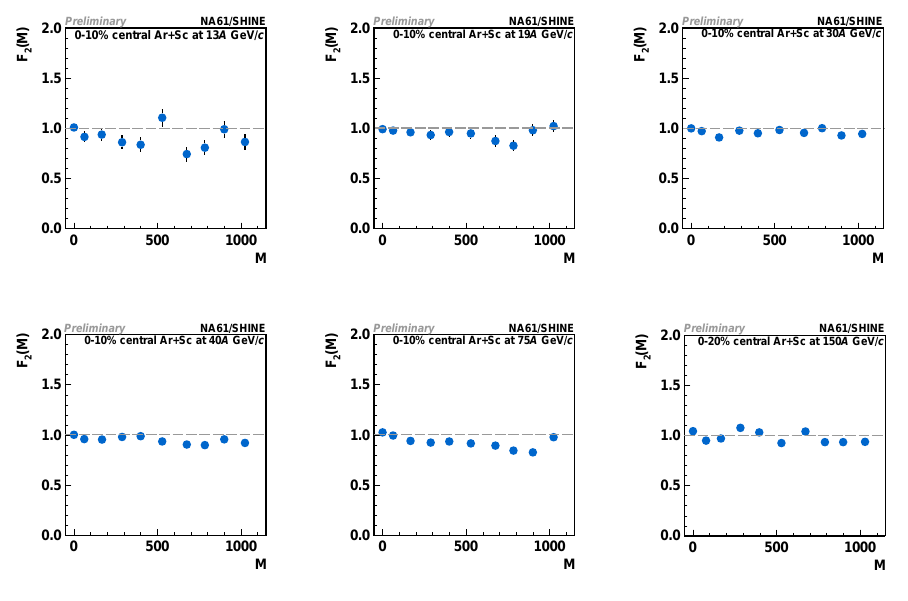
Figure 4. The dependence of the second scaled factorial moment of proton multiplicity distribution on the number of subdivisions in cumulative transverse-momentum space M for 1 ≤ M ≤ 32 2 for central (0-10%) 40 Ar + 45 Sc at 13 A -75 A GeV/ c and central (0-20%) 40 Ar + 45 Sc at 150 A GeV/ c collisions (from left top to bottom right ). Only statistical uncertainties are